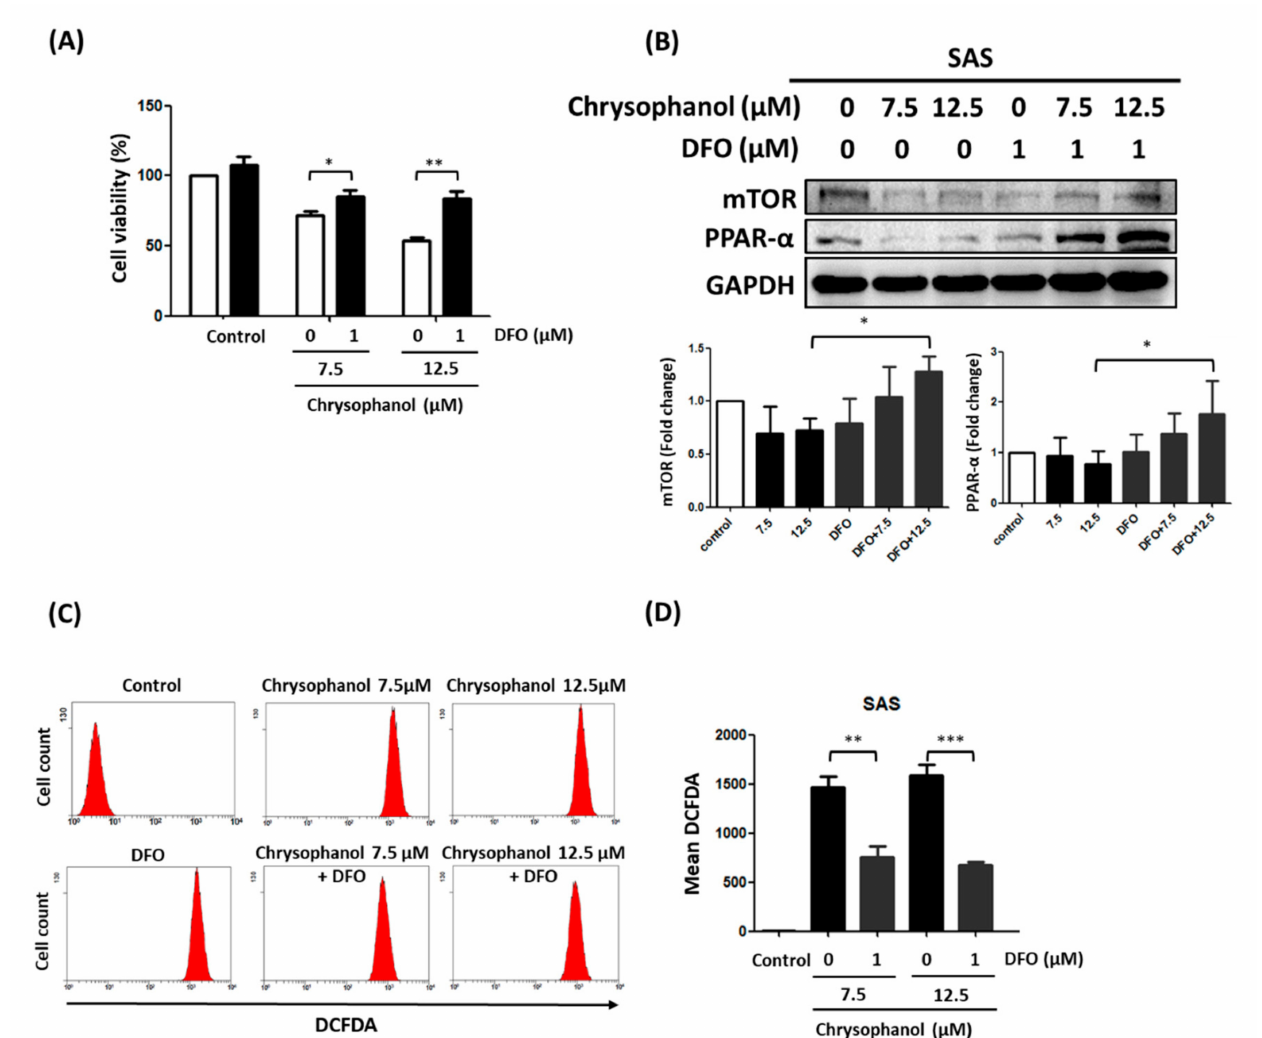
Figure 2. Effect of DFO on cell survival, mTOR/PPAR- α expression, and ROS production in chrysophanol-treated SAS cells. ( A ) WST-1 was used to measure viability of cells in indicated groups. ( B ) Upper panel indicates expression changes of mTOR and PPAR- α proteins in the presence of 0, 7.5, and 12.5 µ M chrysophanol with (1 µ M) or without DFO treatment. Lower panel indicates quantitative results of assessing specific proteins using ImageJ. ( C ) Changes in ROS levels (with 10 µ M DEFDA staining) with 0 (control), 7.5, and 12.5 µ M chrysophanol treatment with (1 µ M) or without DFO treatment. ( D ) Mean fluorescence intensity was used to measure lipid ROS levels. Three independent replicates were used to calculate standard deviation; n = 3. * p < 0.05; ** p < 0.01; *** p <